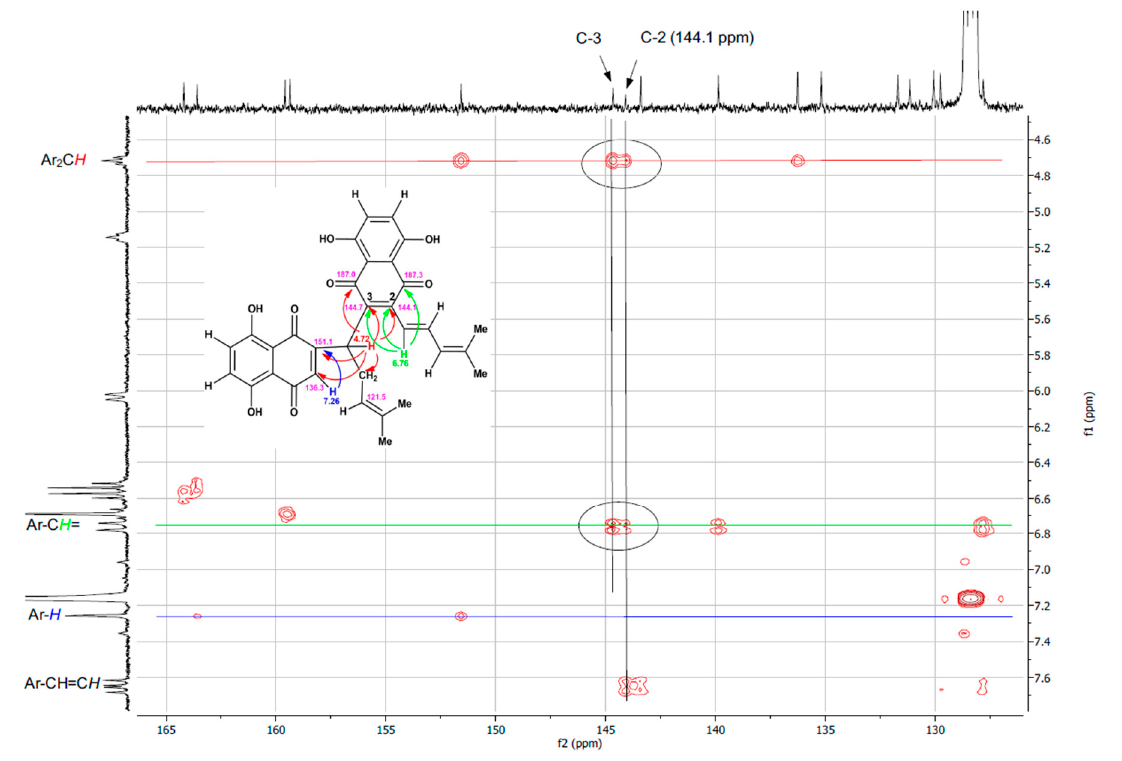
Figure 3. Detail of the HMBC spectrum of SK119, measured in benzene ‐ d6. Table 1. NMR data of SK119, measured in CDCl 3 and benzene ‐ d 6 . *, **, *** Peaks with the same symbol may be interchanged within column. For numbering, see Figure 1.